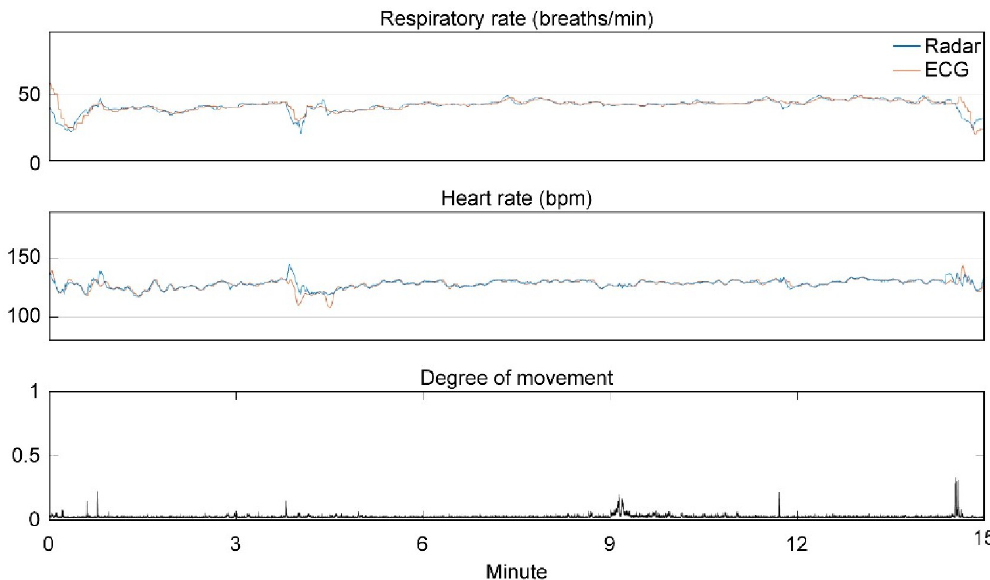
Fig 4. Representative examples of the HR and RR of a premature infant. Representative examples of the HR and RR obtained from a 7-day-old premature infant weighing 3,550 g (gestational age 31+2 weeks, birth weight 3,400 g) during sleeping. The blue and red lines represent measurements from the radar (RR Rd , HR Rd ) and ECG/IPG (RR IPG , HR ECG ) over 15 minutes, respectively. The degree of movement is presented with arbitrary units based on the distance from the IR-UWB radar (the lowest panel). The measurements from the two methods agreed well with each